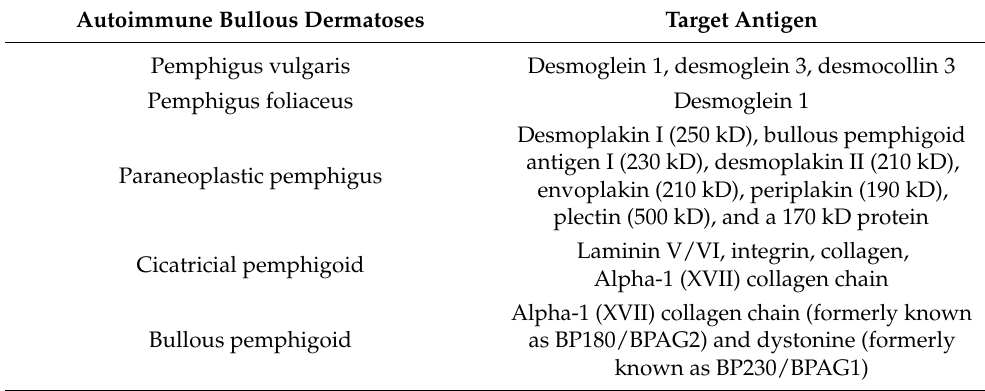
Table 2. Target antigens specific for the most common autoimmune bullous dermatoses with oral